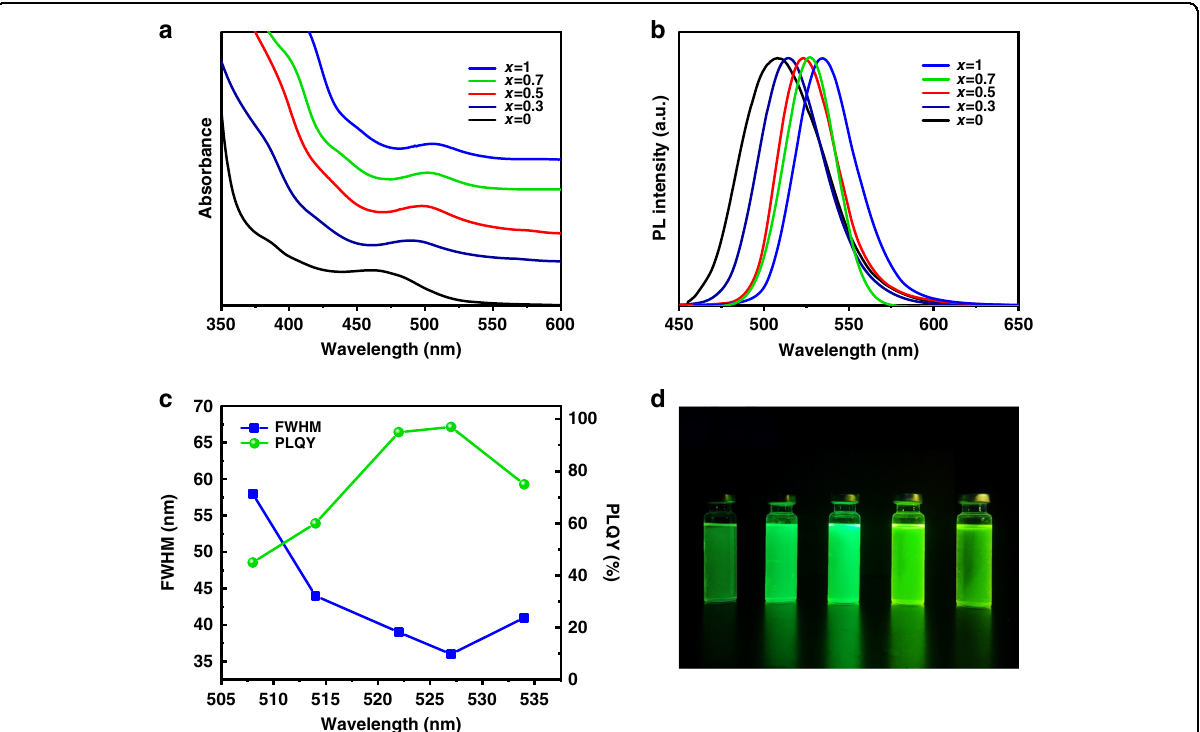
Fig. 2 Optical properties of InP/ZnSe x S 1 − x /ZnS QDs ( x = 0, 0.3, 0.5, 0.7, 1). a , b Absorption and PL spectra of various QDs. c FWHM-PL peak-PLQY of various QDs. d Digital photographs of QDs-solution with the same optical density (0.05) under 365 nm ultraviolet lamp ( x = 0, 0.3, 0.5, 0.7, 1 from left to